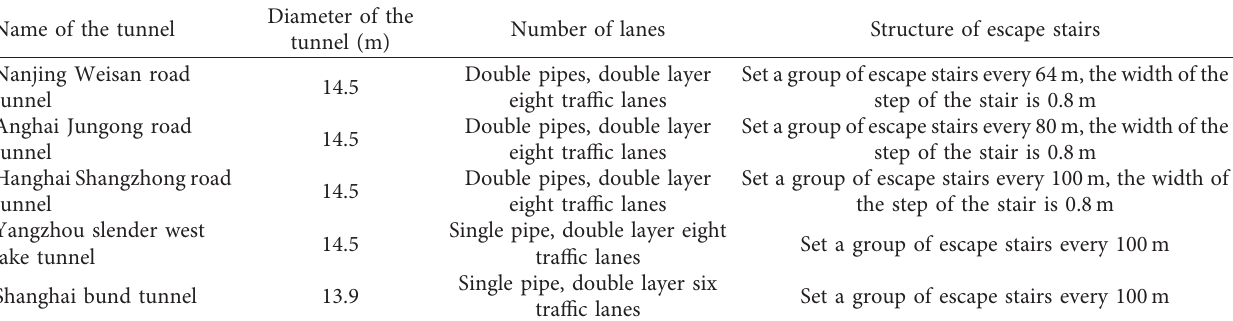
Figure 12: Escape stair spacing design curve. Table 5: Project cases of up and down escape staircase [18,